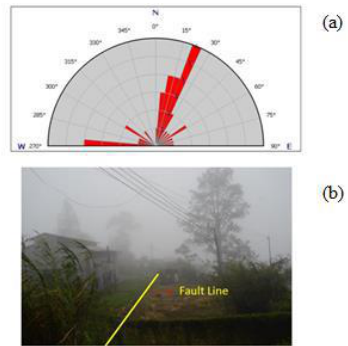
Figure 4. Rose Diagram of inclined trees found at TM Resort creeping landslide (a) that are parallel to the direction of nearby fault line (b) From the histogram of the tree inclination angle at the TM Resort plot, it shows that the inclination angle ranges between 63º and 90º (Figure 5). Inclination angle is the angle of tree trunk from the ground, in which the ground is set as 0º. The plot was mostly covered by matured trees and small (37º to 10º) inclination angles reflect the speed of movement of the